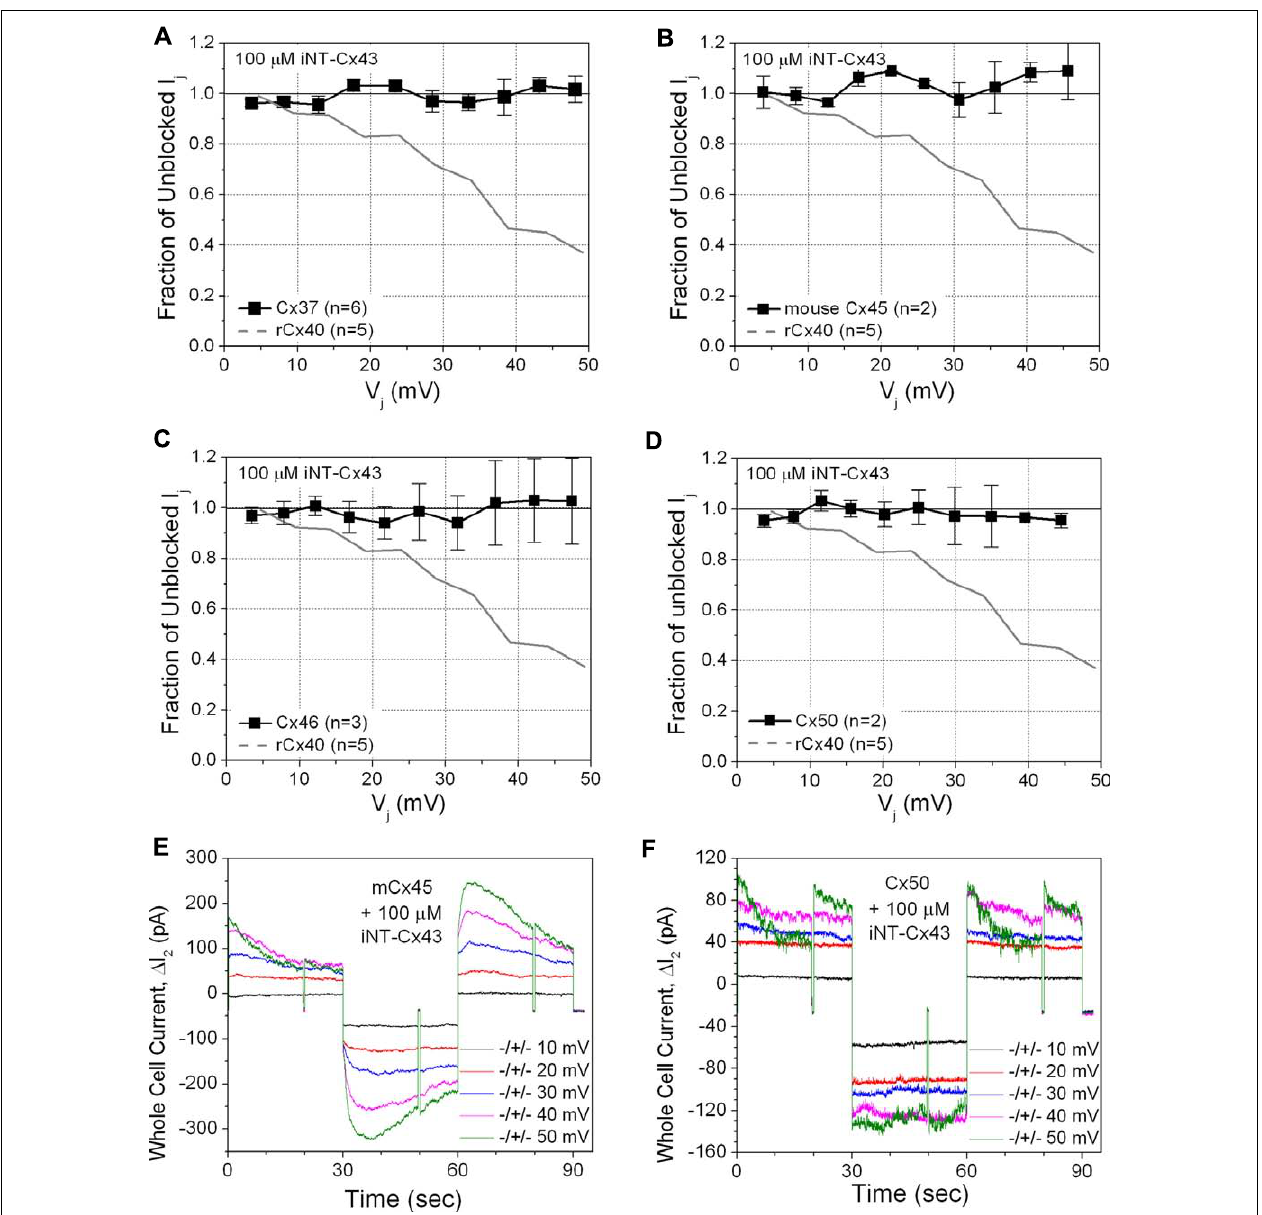
FIGURE 3 |The ability of the iNT-Cx43 peptide to inhibit Cx37 (A), Cx45 (B), Cx46 (C), and Cx50 (D) gap junctions was tested using the same V j -dependent block protocol as in Figure 2. As a reference, the blockade of rCx40 I j (continuous gray line) is illustrated in each panel. Unlike rCx40, none of these four connexin gap junctions were significantly inhibited by 100 μ M iNT-Cx43 peptide. Actual Δ I 2 current traces from Cx45 (E) and Cx50 (F) cell pair iNT-Cx43 peptide experiments illustrating the lack of I j current block